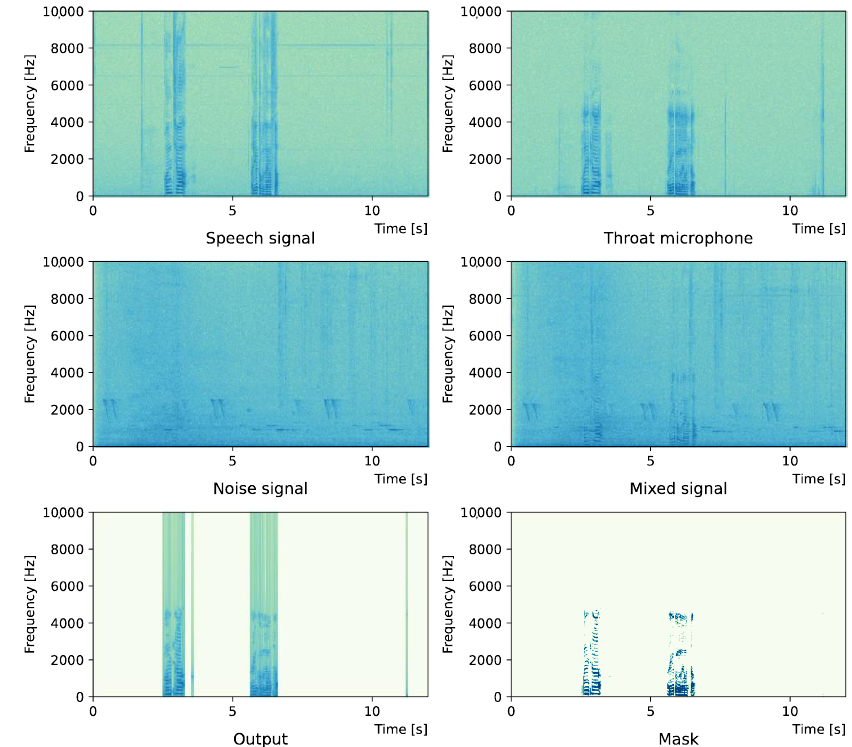
Figure 2. Waveform (Intersection noise).